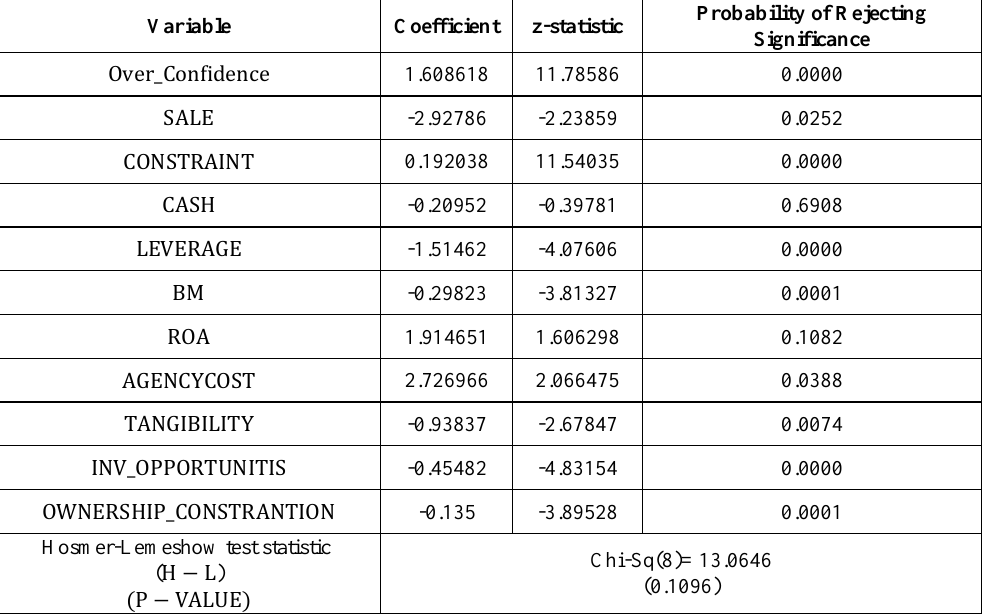
Table 4. Estimation results by probit method (dependent variable: corporate overinvestment)